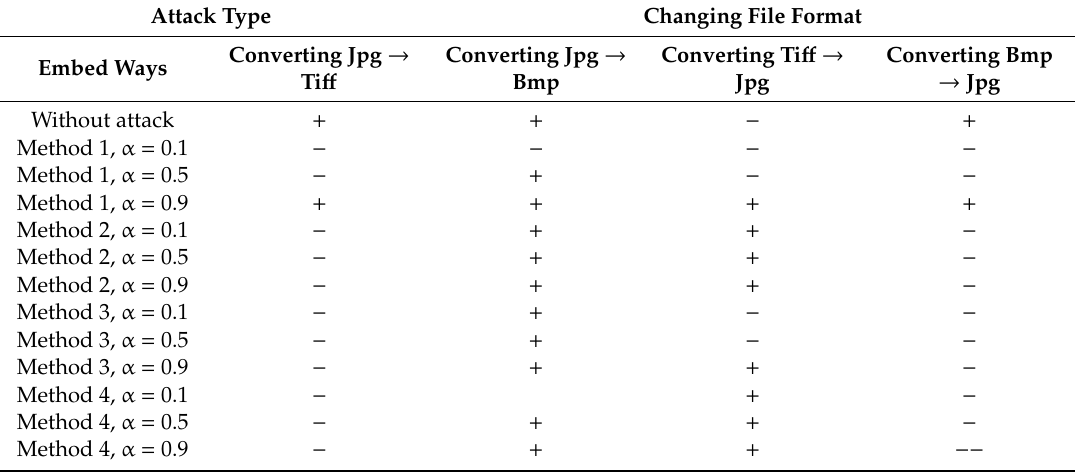
Table 6. The results of the experiments of the conducted attacks of the type of format conversion to verify the e ff ectiveness of the method on the example of the test image “Lena” by Equation (34) m = 1 / 3, n = 1.